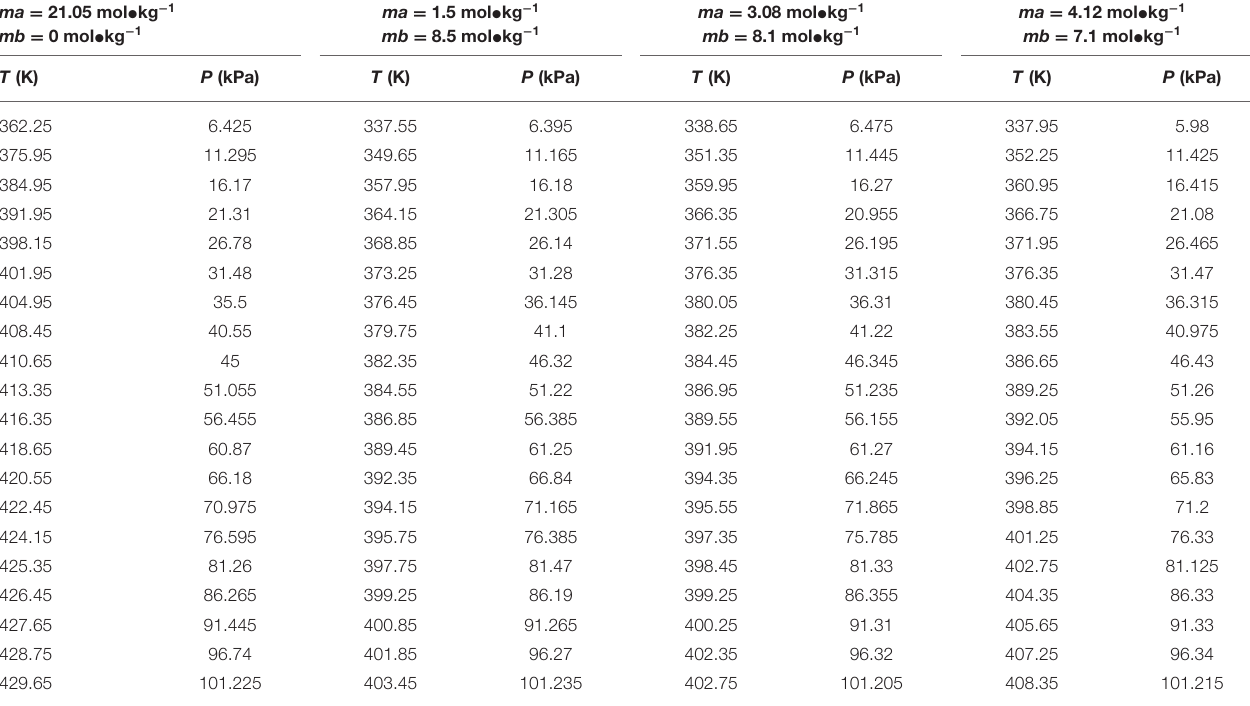
TABLE 4 | Experimental VLE data for temperature T , pressure P , and molality m ( ma— LiBr, mb— CaCl 2 ) for the LiBr + CaCl 2 + H 2 O